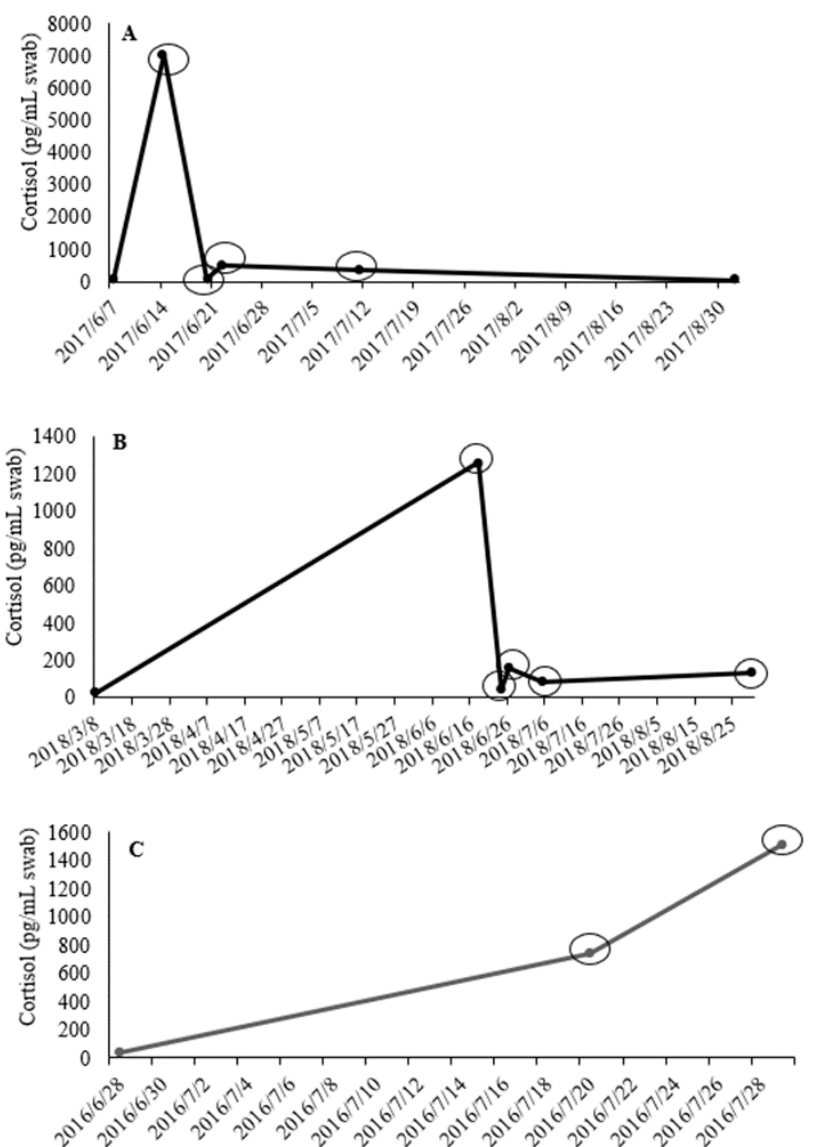
Figure 2. Skin mucus cortisol values (pg/mL swab) from a post-acclimation sample during when the molas were considered healthy to time of illness and recovery ( A ), injury ( B ), and signs of illness that lead to euthanasia ( C ). Circles indicate an elevated cortisol value (≥1.5-fold increase [33]) compared to the post-acclimation sample.